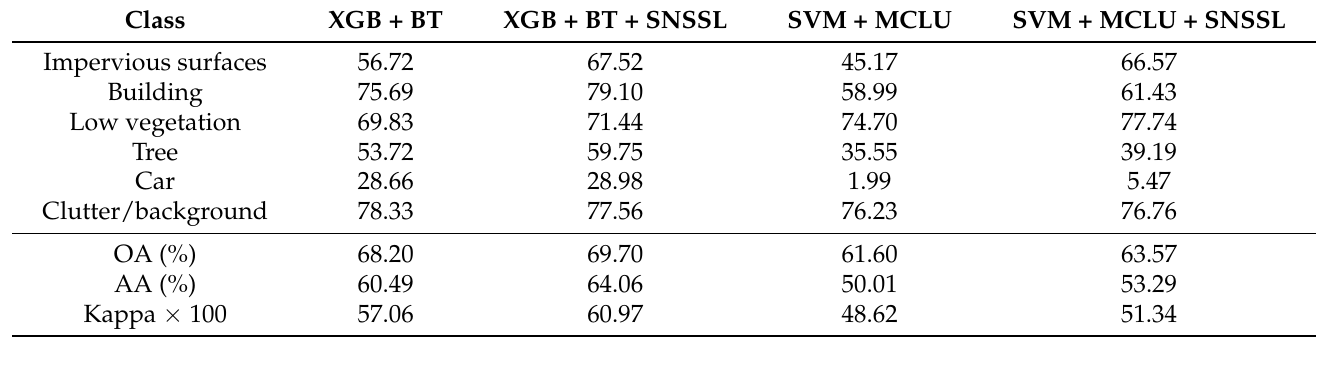
Table 6. Classification accuracy (averaged on 5 runs) of the Potsdam-3_10.